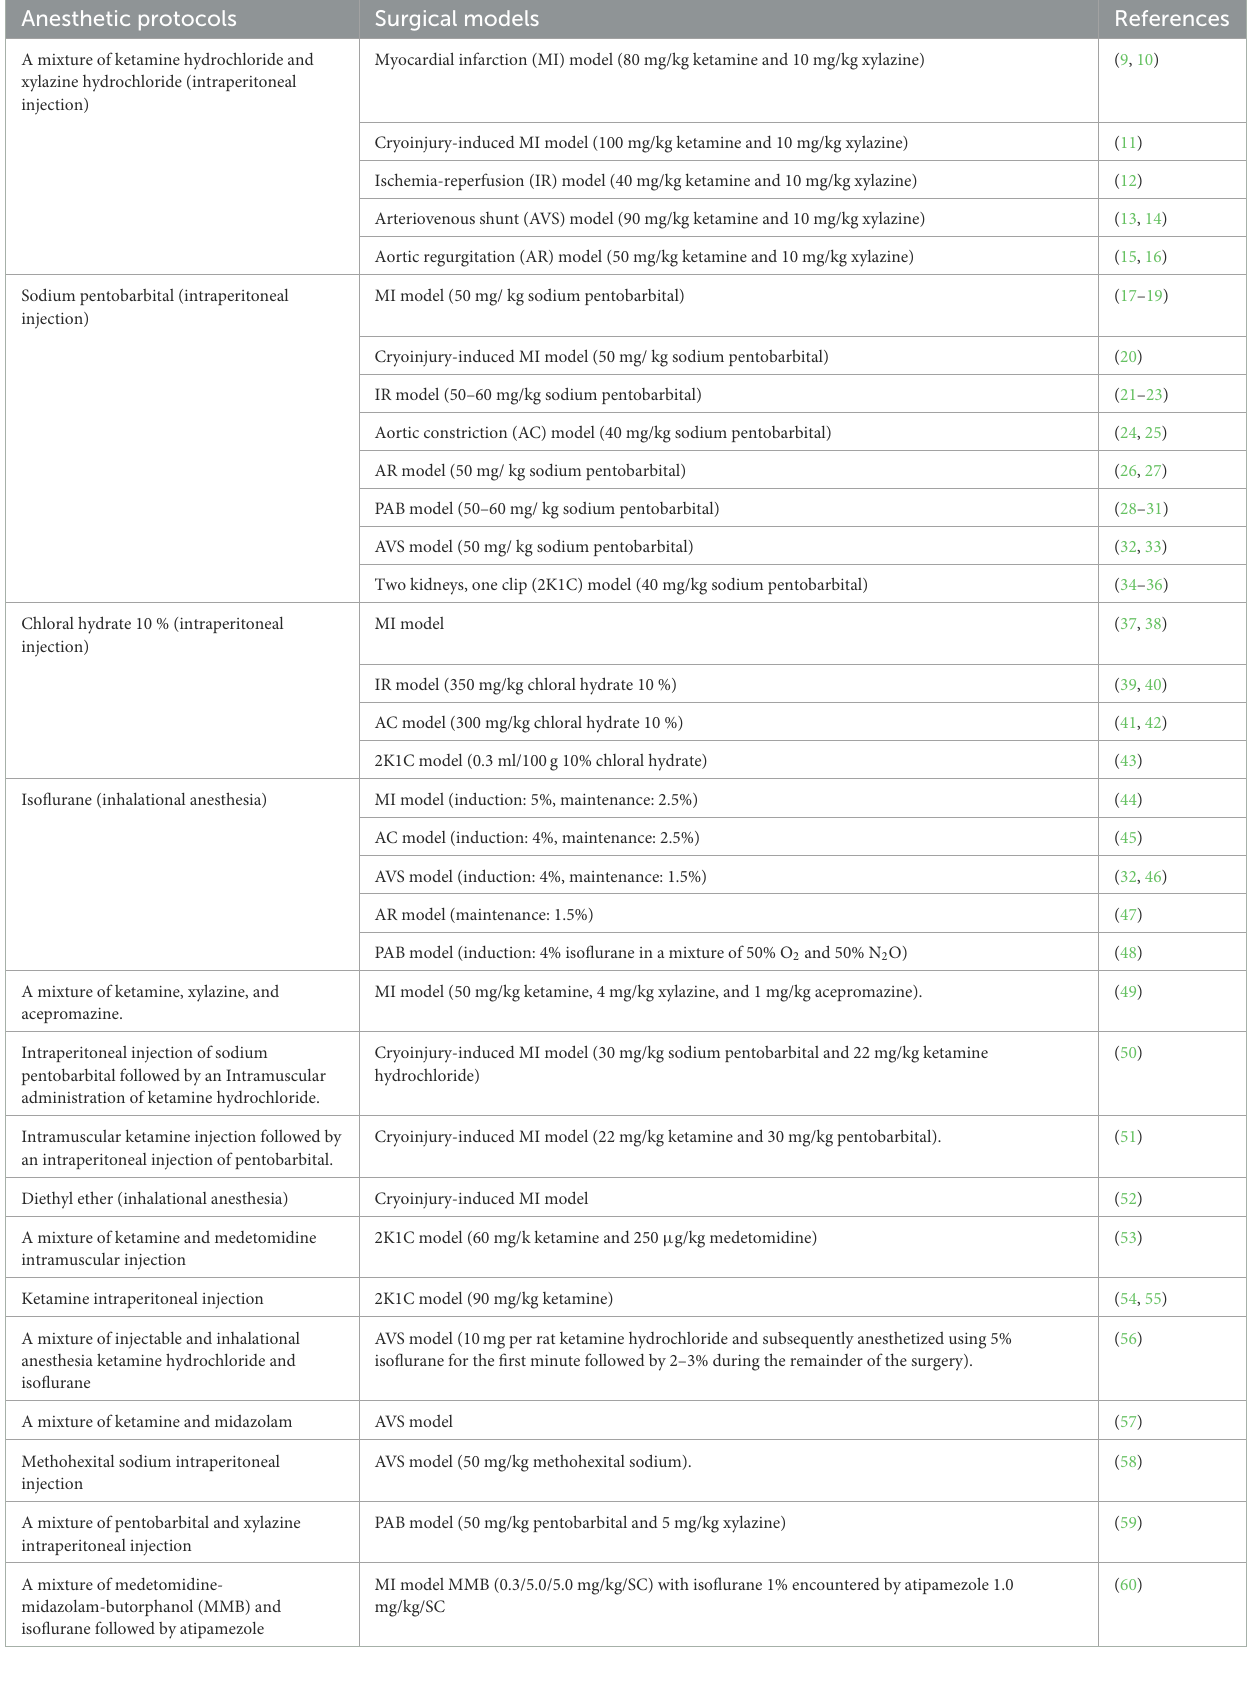
TABLE 1 Different anesthetic protocols used for the induction of experimental surgical models of heart failure in rats. Anesthetic protocols Surgical